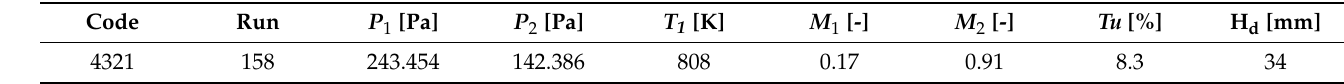
Table 2. Analyzed case